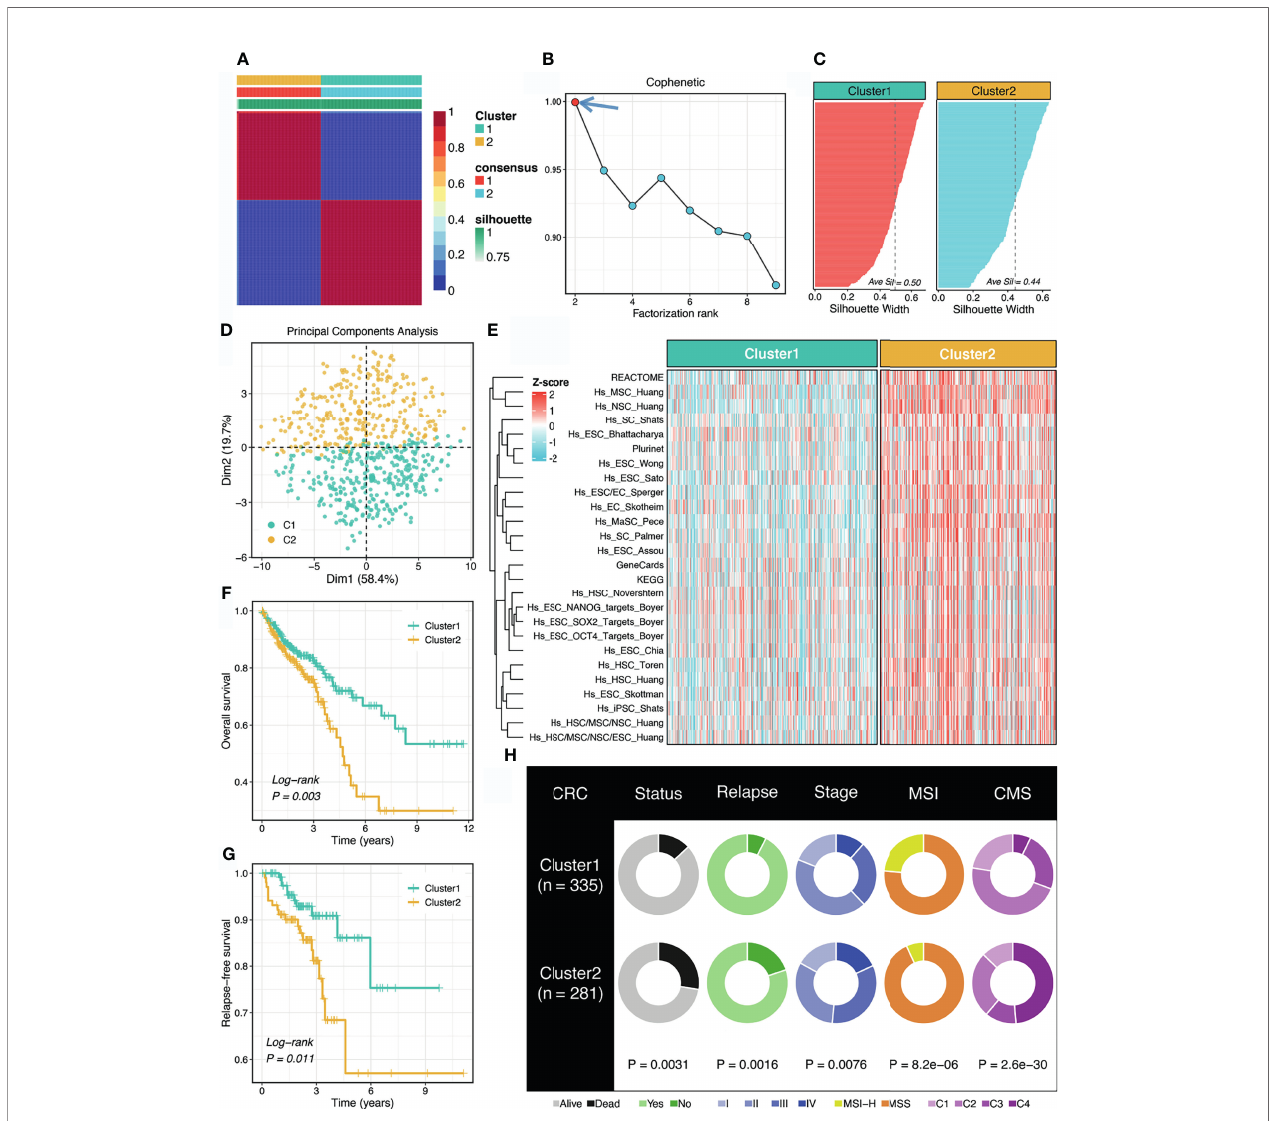
FIGURE 1 | Non-negative matrix factorization (NMF) identi fi ed two stemness clusters with heterogeneous prognosis and clinical features. (A) The consensus map of NMF clustering results in the TCGA-CRC dataset. (B) The fi rst rank (= 2) for which the cophenetic coef fi cient starts decreasing was generally de fi ned as the optimal rank. (C) The silhouette statistic of two stemness clusters. (D) The principal component analysis (PCA) algorithm displayed the two-dimension spatial distribution of two clusters. (E) Heatmap demonstrated C2 possessed signi fi cantly higher stemness abundance compared with C1. (F, G) Kaplan-Meier curves of OS (F) and RFS (G) according to the stemness clusters. (H) Distributions of clinical features between two